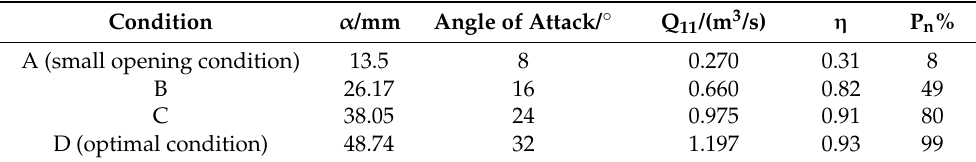
Table 2. Details of working